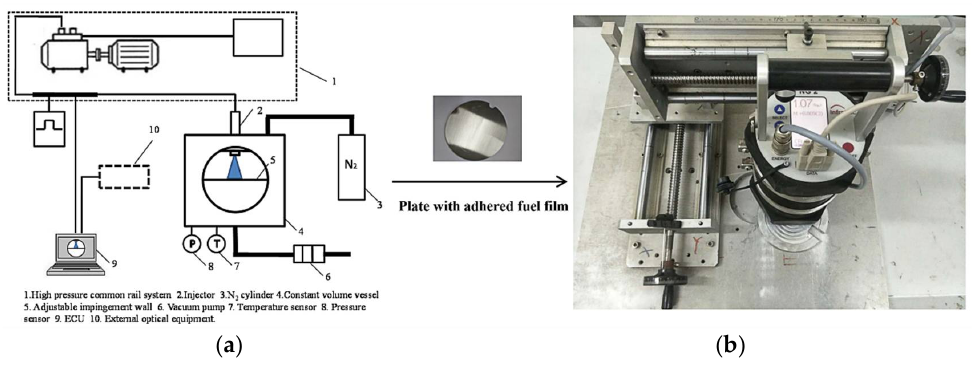
Figure 1. Spray impingement and film-thickness measurement system: ( a ) schematic diagram of spray-impingement test rig [30]; ( b ) wall film thickness measurement instrument [31].